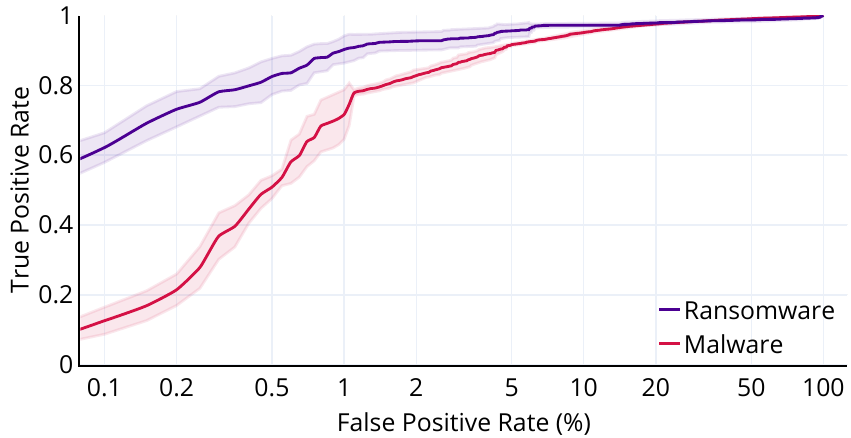
Figure 6. Average ROC curve of the MLP classifier over the five repetitions of the 10-fold cross-validation. The lines for the ransomware and malware classes include the standard deviation in translucent color.